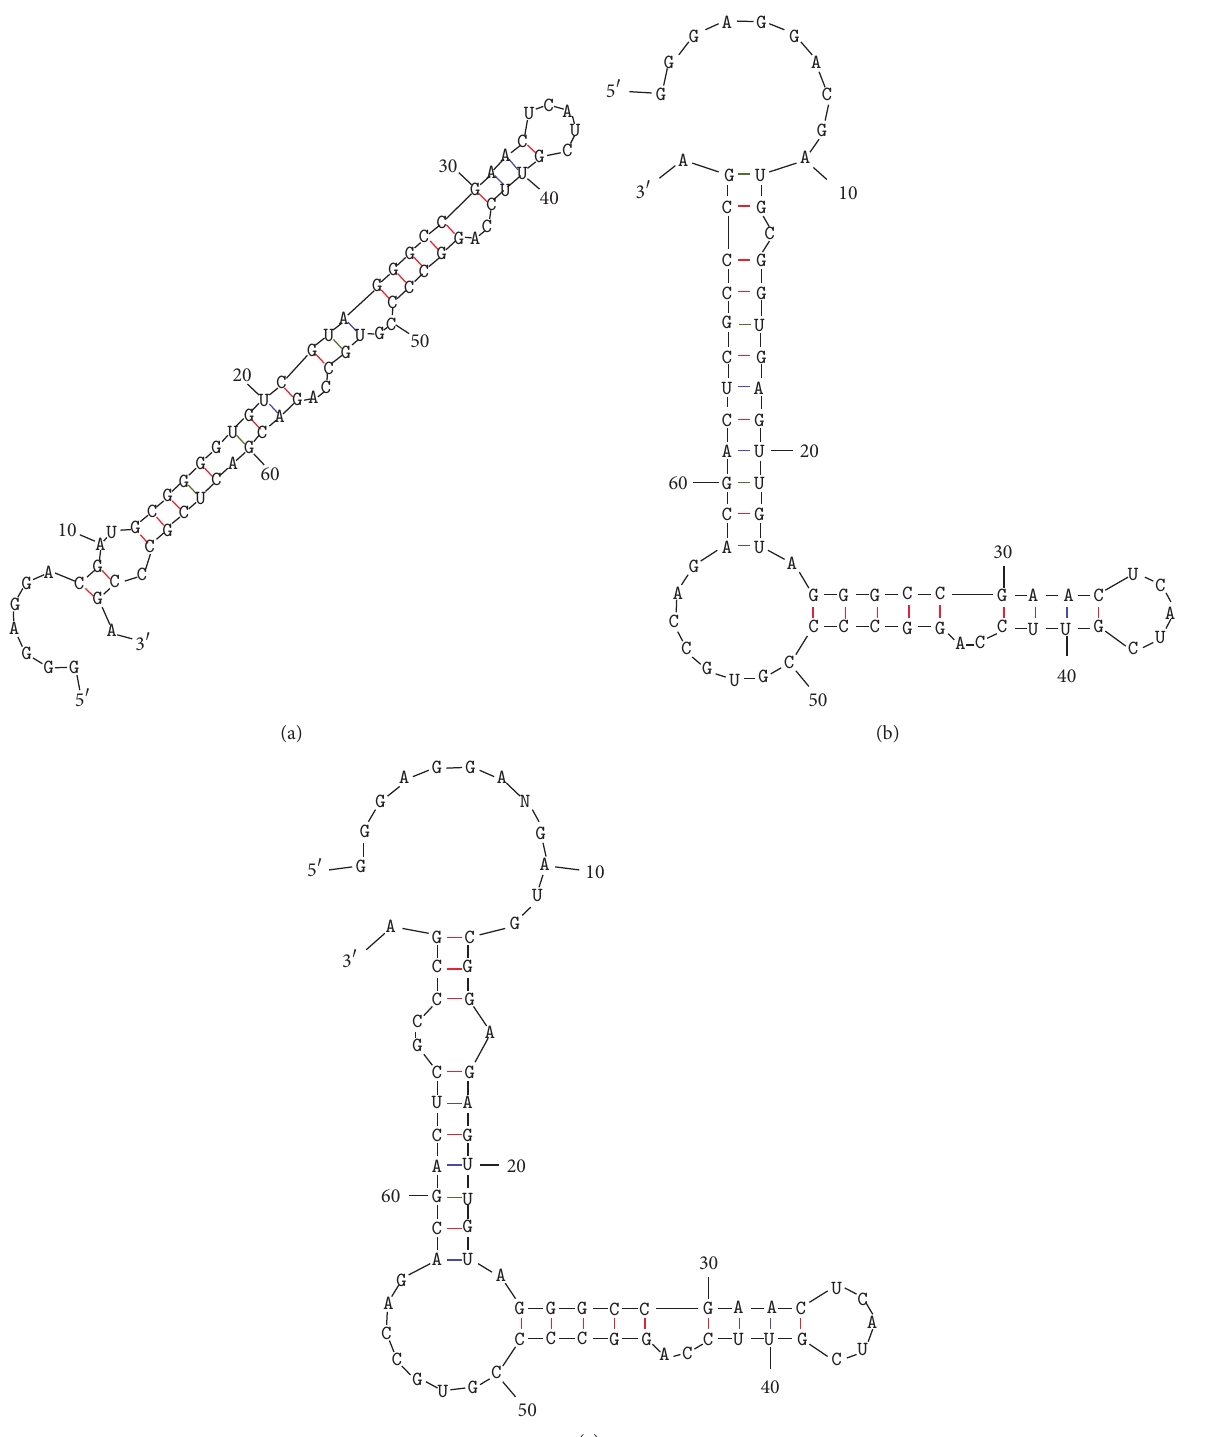
Figure 1: Secondary structure of the identified clones (a) M7-14, (b) P7-1, and (c) P7-14 predicted by the M-fold program [7].